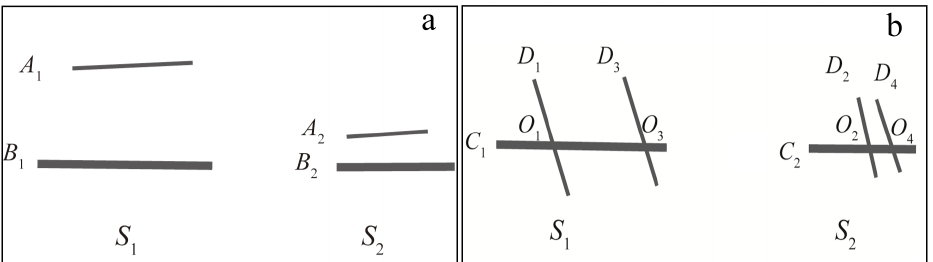
Figure 3. Road topological relations at different scales: ( a ) the disjoint relationship and ( b ) intersec- tion relationship.